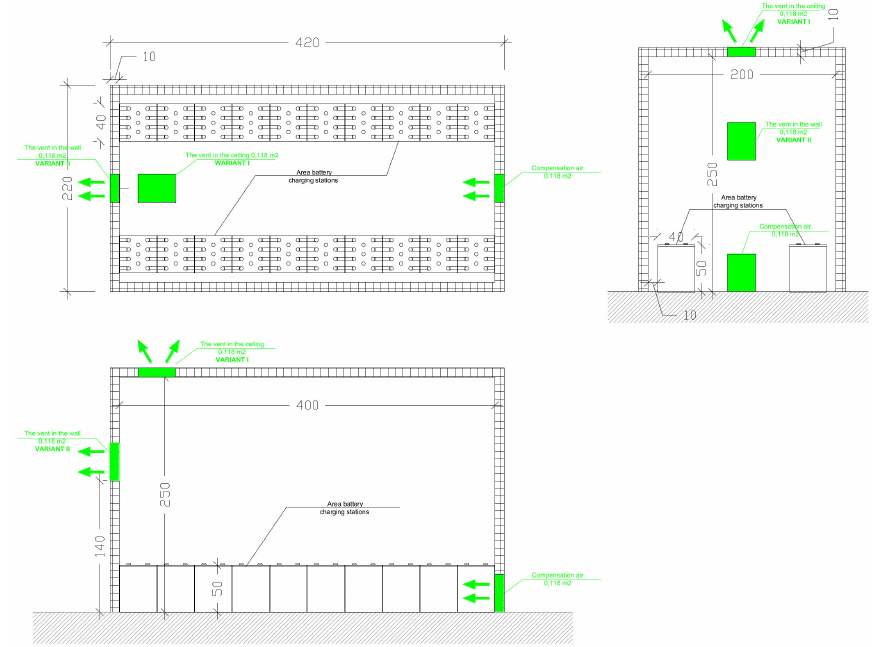
Figure 8. The natural ventilation system scheme with alternative exhaust point in the ceiling and supply point near the floor.